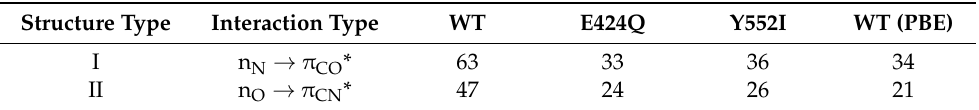
Table 4. Average values of the second order perturbation theory estimates of the interaction strength for types I and II structures for the WT GCPII, its E424Q and Y552I mutants calculated at the PBE0 level, and for the WT enzyme calculated at the PBE level. The energies (kcal/mol) account for the extent of delocalization between either I or II type structures and the structure III, which is considered as the most reactive one (see Figure 7B). Structure